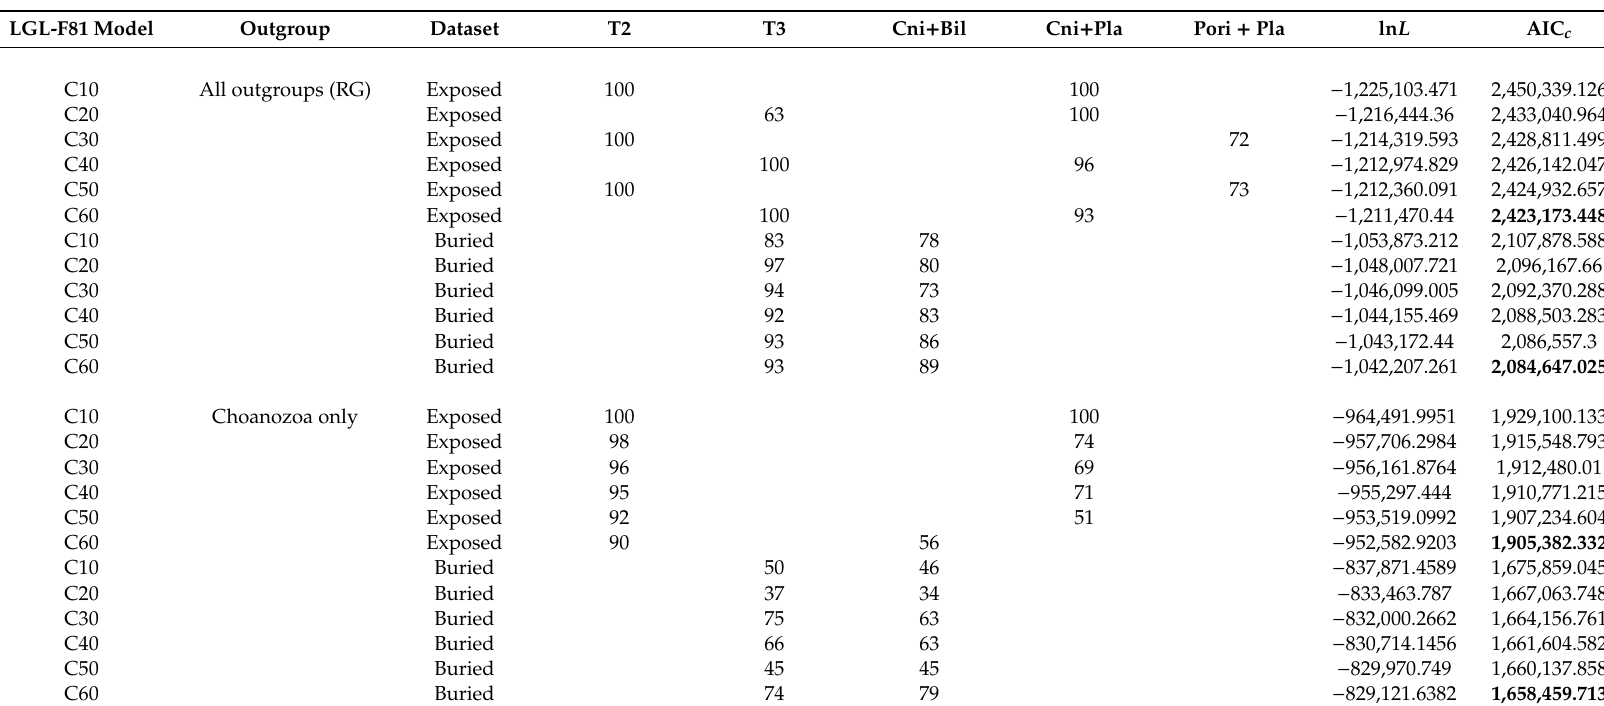
Table 3. Log likelihood and AIC c scores for various CAT-F81 models as implemented in IQ-TREE. The best-fit model is indicated by the bold AIC c value. LGL-F81